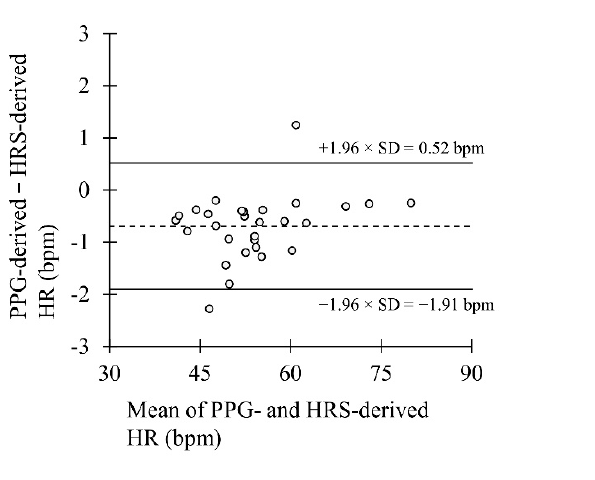
Figure 5. ( a ) Correlation between PPG- and HRS-derived nocturnal HR ( b ) Correlation between PPG and HRS-derived nocturnal LnRMSSD.